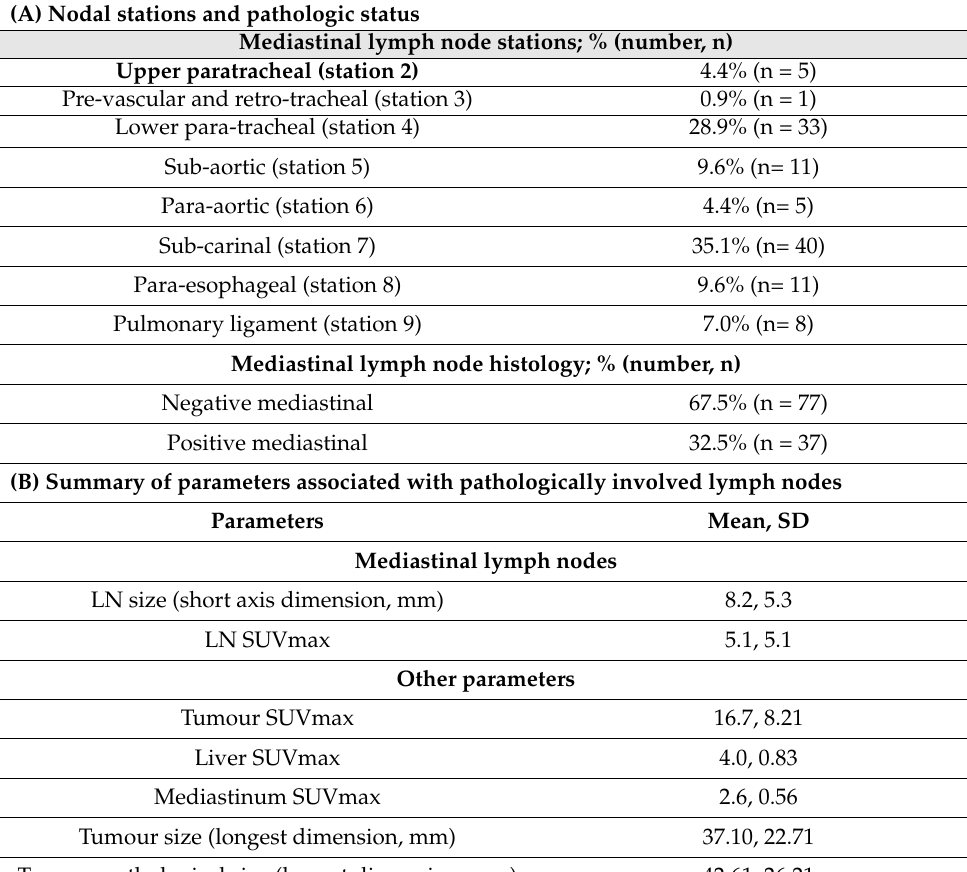
Table 2. Lymph node characteristics and associated correlations.